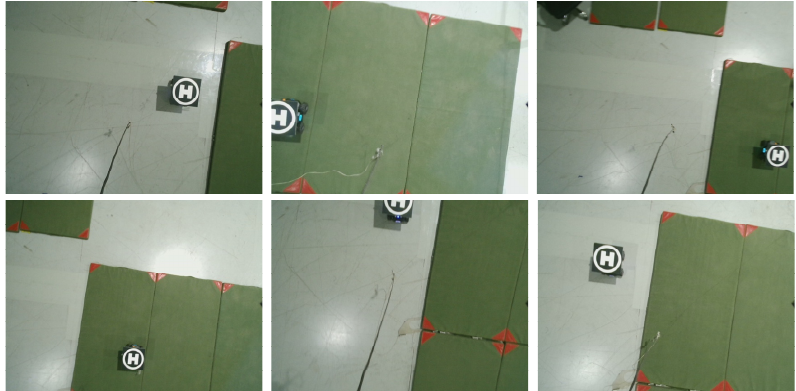
Figure 6. Part of the dataset for perception network training.